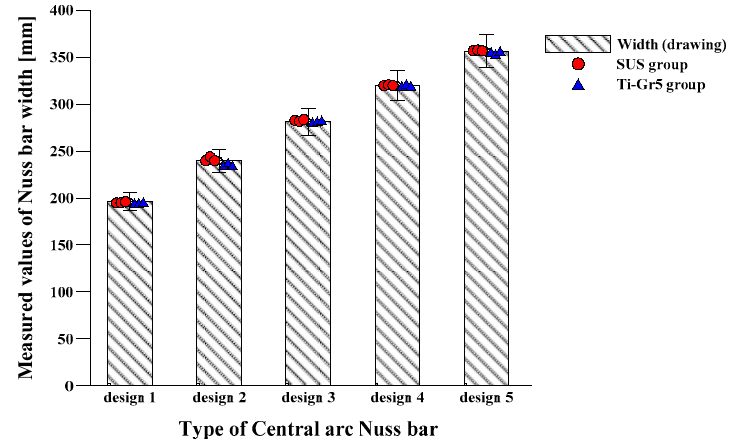
Figure 16. This histogram shows the dimensions of the Nuss bar. The maximum width of SUS and Ti-Gr5 central arc Nuss bars was measured and compared with original width.